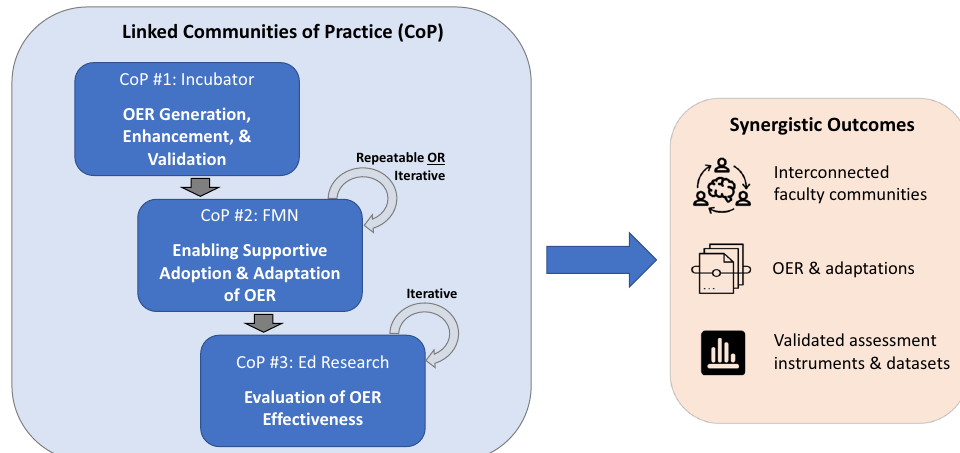
Fig. 1 The linked CoP framework for OER development and professional capacity building. Linked CoPs function to create OERs, train and support faculty in their use, and evaluate their educational effectiveness. Synergistic outcomes from the combined CoPs include professional capacity building yielding interconnected faculty communities, OER and adaptations, and validated assessment instruments and datasets. Icon credits: Ideation Cycle by Weltenraser from NounProject, Bundle by Siipkan Creative from NounProject, and Assessment by Justin Blake from